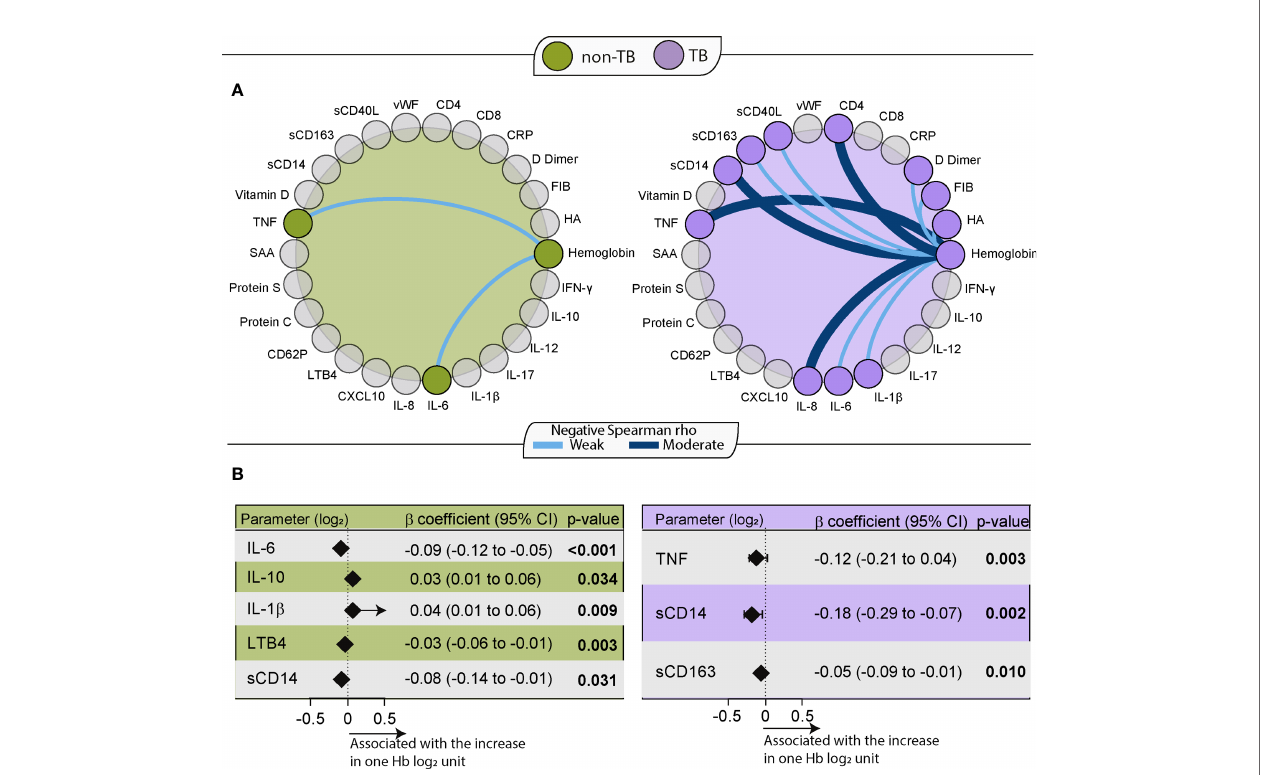
FIGURE 2 | Hemoglobin levels are related to the in fl ammatory pro fi le of HIV-TB participants. (A) Spearman correlation test between Hb levels and laboratory measurements for each group (Green: non-TB; Purple: TB). Light blue lines indicate a weakly negative (rho <0.40) correlation, and dark blue lines indicate a moderately strong negative (0.4 ≤ rho <0.6) correlation between the linked parameters. All correlations in this chart had p value less than 0.05. (B) Backward stepwise linear regression to identify biomarker measurements independently associated with Hb levels. All parameters were log2 transformed. Only signi fi cant parameters in the last step are shown. Left: non-TB (green). Right: TB